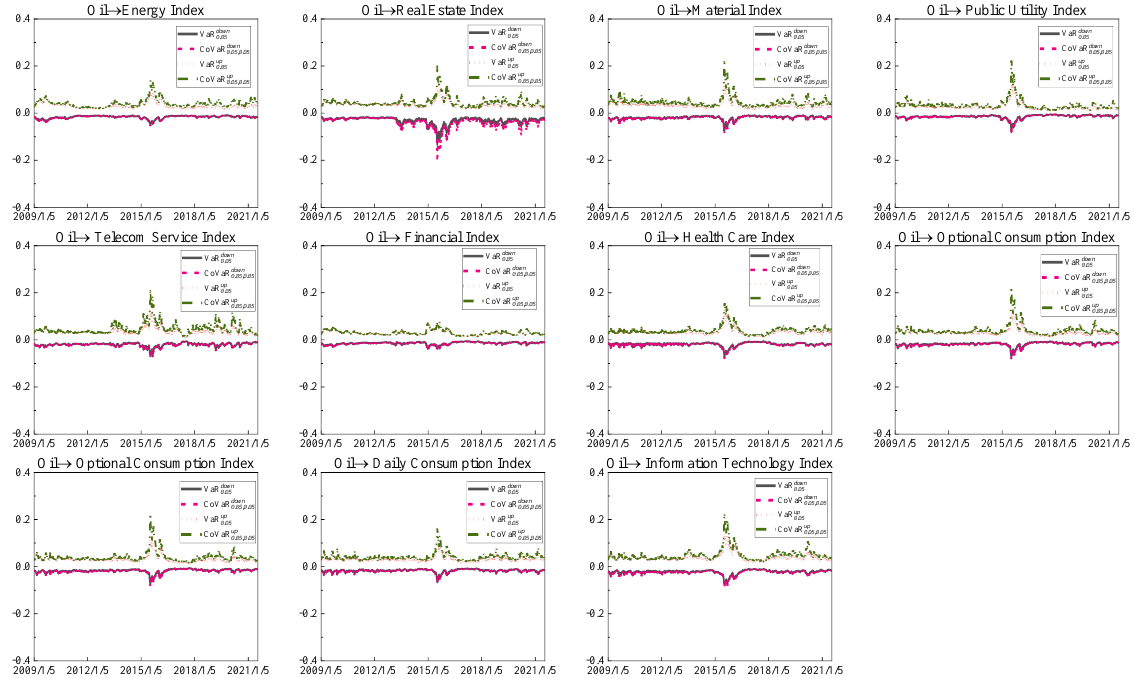
Figure 1. Tail risks of extreme oil market on Chinese sectoral stock indexes.